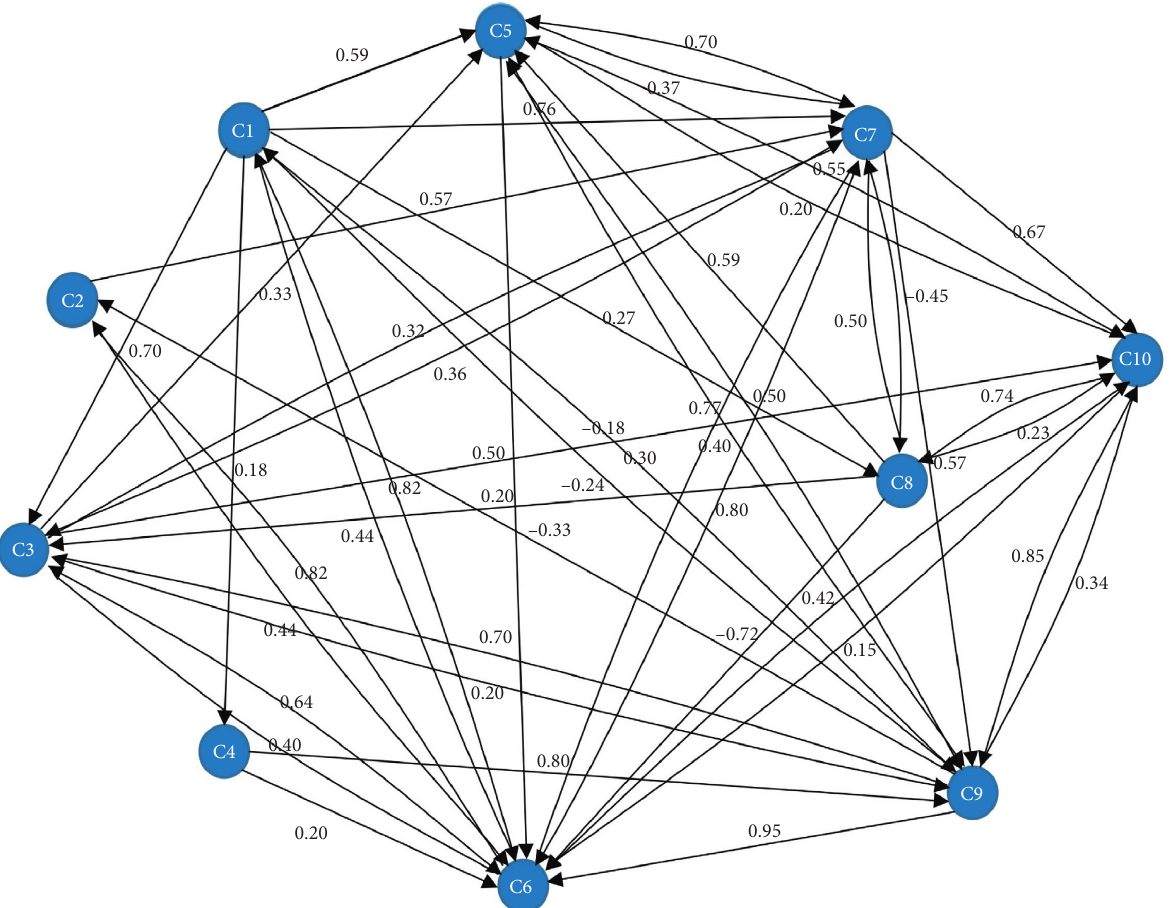
Figure 3: Interactive justice, relational embeddedness, and governance performance